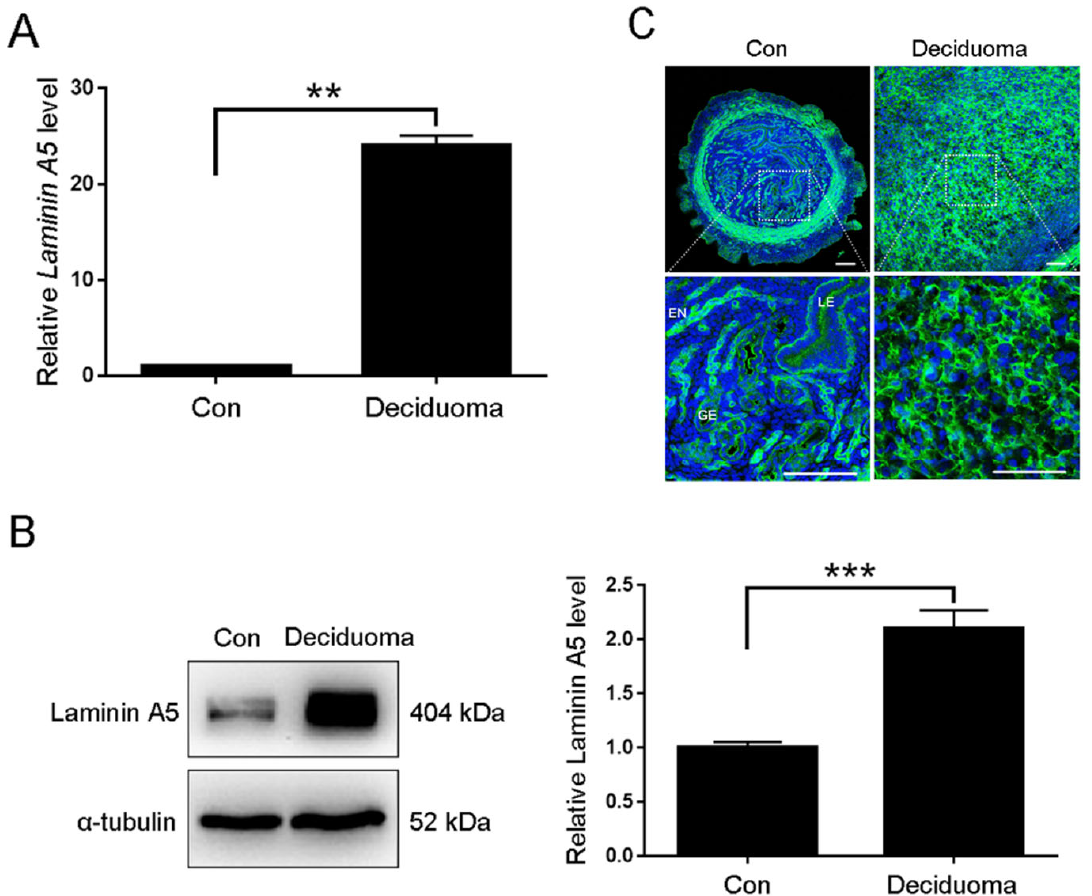
Figure 2. Laminin A5 expression during artificial decidualization. ( A ) RT ‐ qPCR analysis of Laminin A5 mRNA level. ( B ) Western blot analysis of laminin A5 protein level. ( C ) Laminin A5 immunoflu ‐ orescence. EN, endothelium; GE, glandular epithelium; LE, luminal epithelium. Scale bar = 100 μ m. Bars represent mean ± SD (** p ‐ value < 0.01, *** p ‐ value < 0.001).